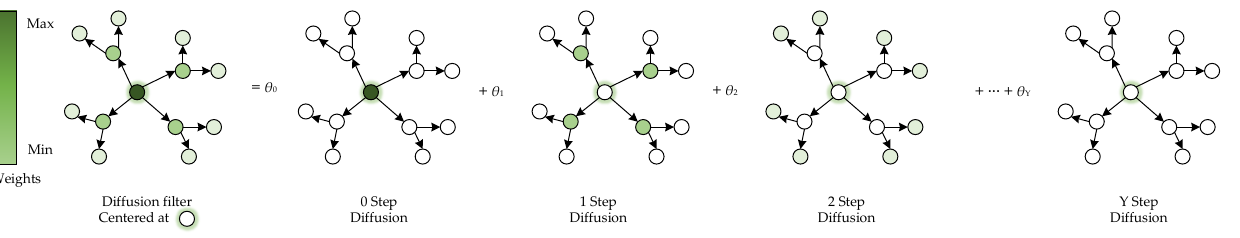
Figure 1 . Illustration of the graph diffusion process with Y diffusion steps on a schematic graph.